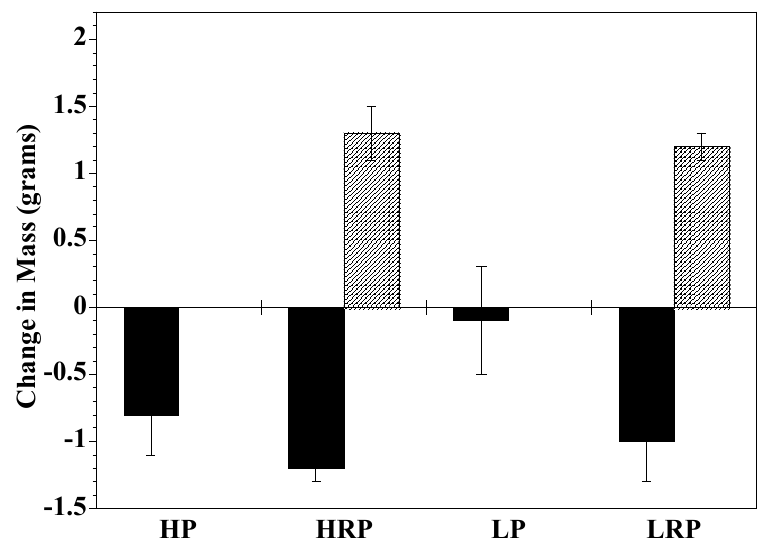
Figure 2. Gross change in mean individual mass (grams) of yellow perch (solid columns) and ruffe (striped columns) by treatment (plus or minus one standard error) during the six-week ruffe and fish density experiment. There are four replicates of each treatment except LRP ( n = 3). HP = 28 perch, HRP = 14 perch + 14 ruffe, LP = 14 perch, and LRP = 7 perch + 7 ruffe. As in the first experiment, ruffe growth was generally greater than perch growth in the density gradient experiment (Figures 3 and 4). Growth rate of all fish decreased as the number of ruffe increased (ANOVA, p = 0.043) (Figure 3). The two trials (August–September and September–October) were not significantly different (ANOVA, p = 0.110) and, because there was no significant interaction between ruffe density and species, the decrease in growth with increasing ruffe density was the same for perch and ruffe. Growth rate of perch and ruffe decreased at − 0.037% * d − 1 * ruffe − 1 . This slope was significantly different from zero ( t test, p = 0.006) and was not significantly different from a linear decrease (ANOVA, p = 0.552). The addition of perch to a constant density of ruffe did not have a significant effect on either ruffe or perch growth rate (all p > 0.1, Figure 4). There was a significant difference between the mean growth of ruffe and perch (ANOVA, p < 0.001); ruffe grew faster than perch, who lost mass.